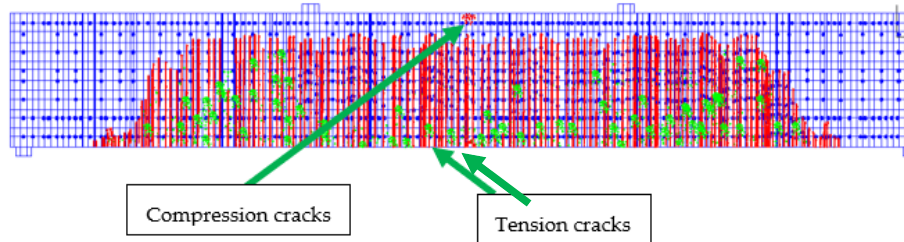
Figure 13. Cracks at failure of specimenS0.